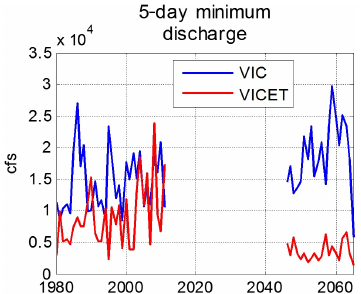
Figure 3. Changes in climate in the coming decades will presum- ably be accompanied by changes in hydrological behavior at the Earth’s surface – changes in the character, for example, of stream- flow. Our estimates of such changes, however, may be severely lim- ited by biases in the models used to quantify them. This is demon- strated here with two simulations of hydrological behavior in the Connecticut River basin, one using the default VIC model and the other using a version of VIC with bias-corrected evapotranspiration (VICET). The VICET model overwrites the model-estimated ET components from VIC with bias-corrected values, and such correc- tion propagates to improve the estimation of other hydrological vari- ables. The meteorological forcing for the two simulations is iden- tical, which for the historical segment was derived from NLDAS-2 (Xia et al., 2012) and for the future segment was constructed based on bias correction of the NARCCAP projection following the ap- proach of Ahmed et al. (2013) using NLDAS-2 as the observational reference. Shown in the plot, for each simulation and for both time periods, are the 5-day minimum discharges at the Thompsonville station (in cubic feet per second). The strong model dependence in the hydrological projections indicates a strong need for careful eval- uation and improvement of land model parameterizations. (Contact: Guiling Wang. See Parr et al. (2015) for further